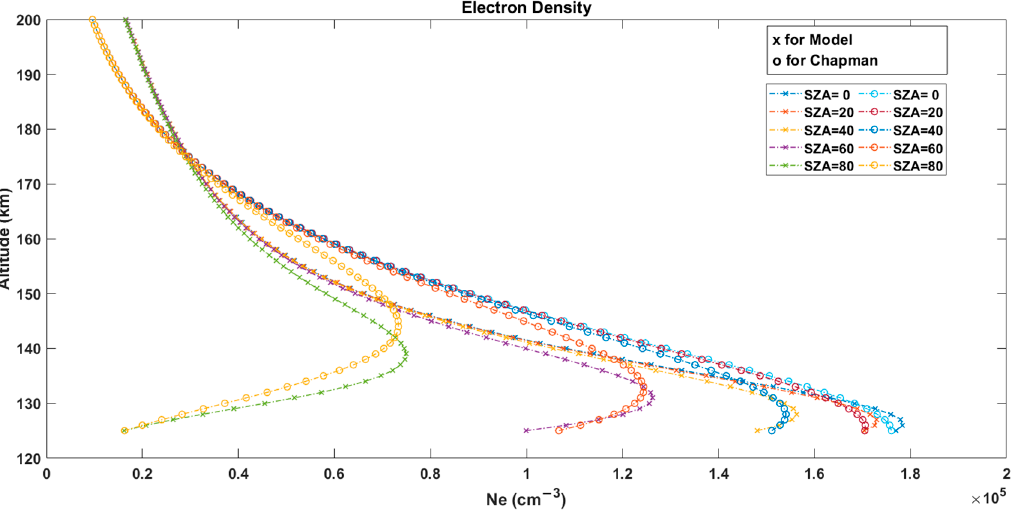
Figure 2. Variations of electron density profiles with SZA estimated from the model (marker with ‘x’) and the Chapman layer (marker with ‘o’).